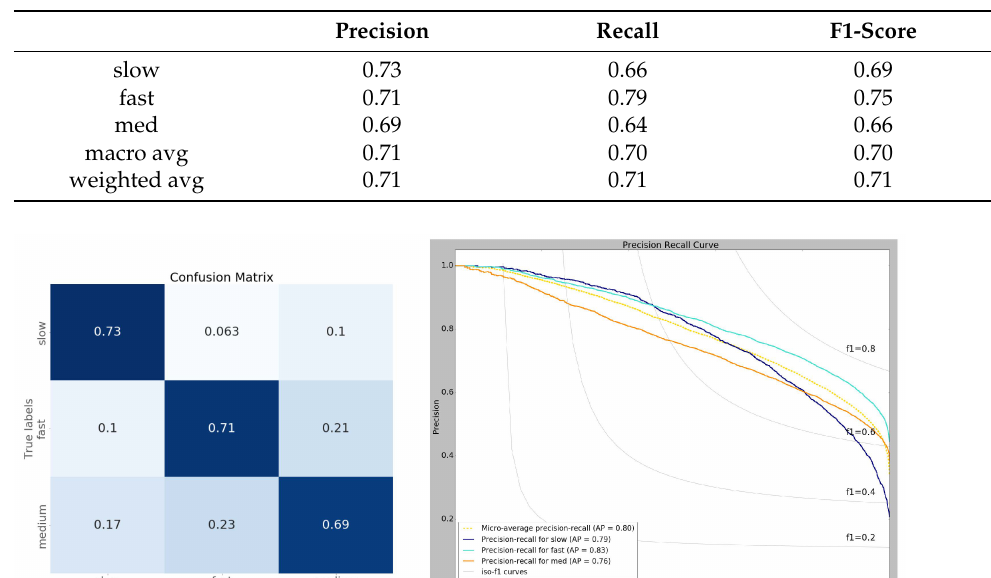
Table 1. Performance metric of the best CNN model. Based on the F1 scores of the RT categories, the model more effectively learned the spatial-spectral patterns of fast and slow RT compared to medium RTs.